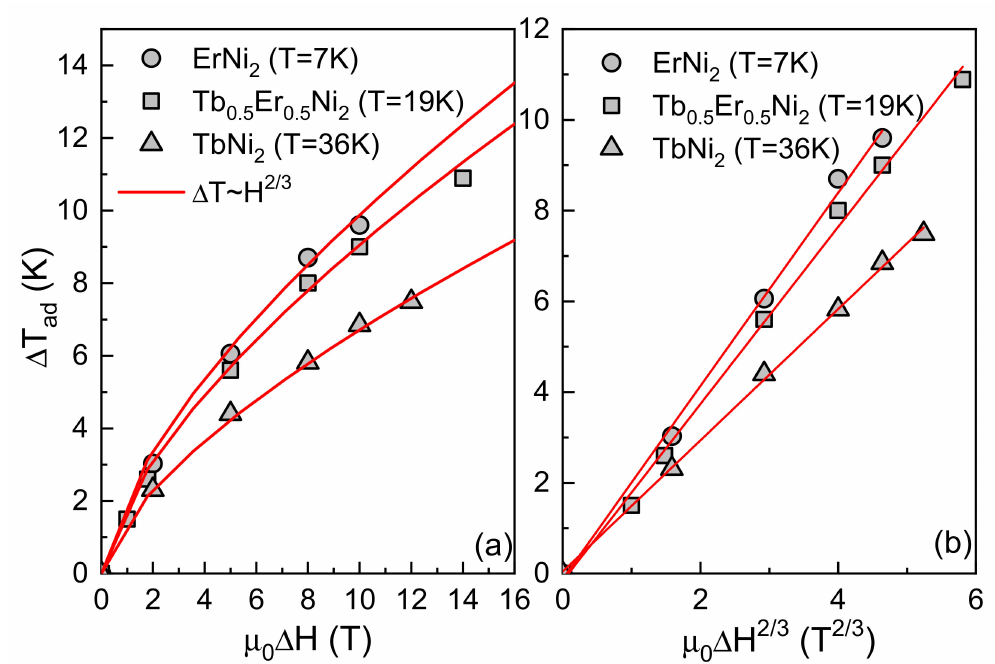
Figure 6. The maximum adiabatic temperature change, ∆ T admax , for TbNi 2 , Tb 0.5 Er 0.5 Ni 2 and ErNi 2 ( a ) as a function of the magnetic field change, µ 0 ∆ H and as a function of ( µ 0 ∆ H ) 2/3 ( b ). Solid lines present the relation ∆ T ad = A( µ 0 ∆ H ) 2/3 , with A listed in Table 3. The results for the binary TbNi 2 and ErNi 2 compounds are taken from Refs.